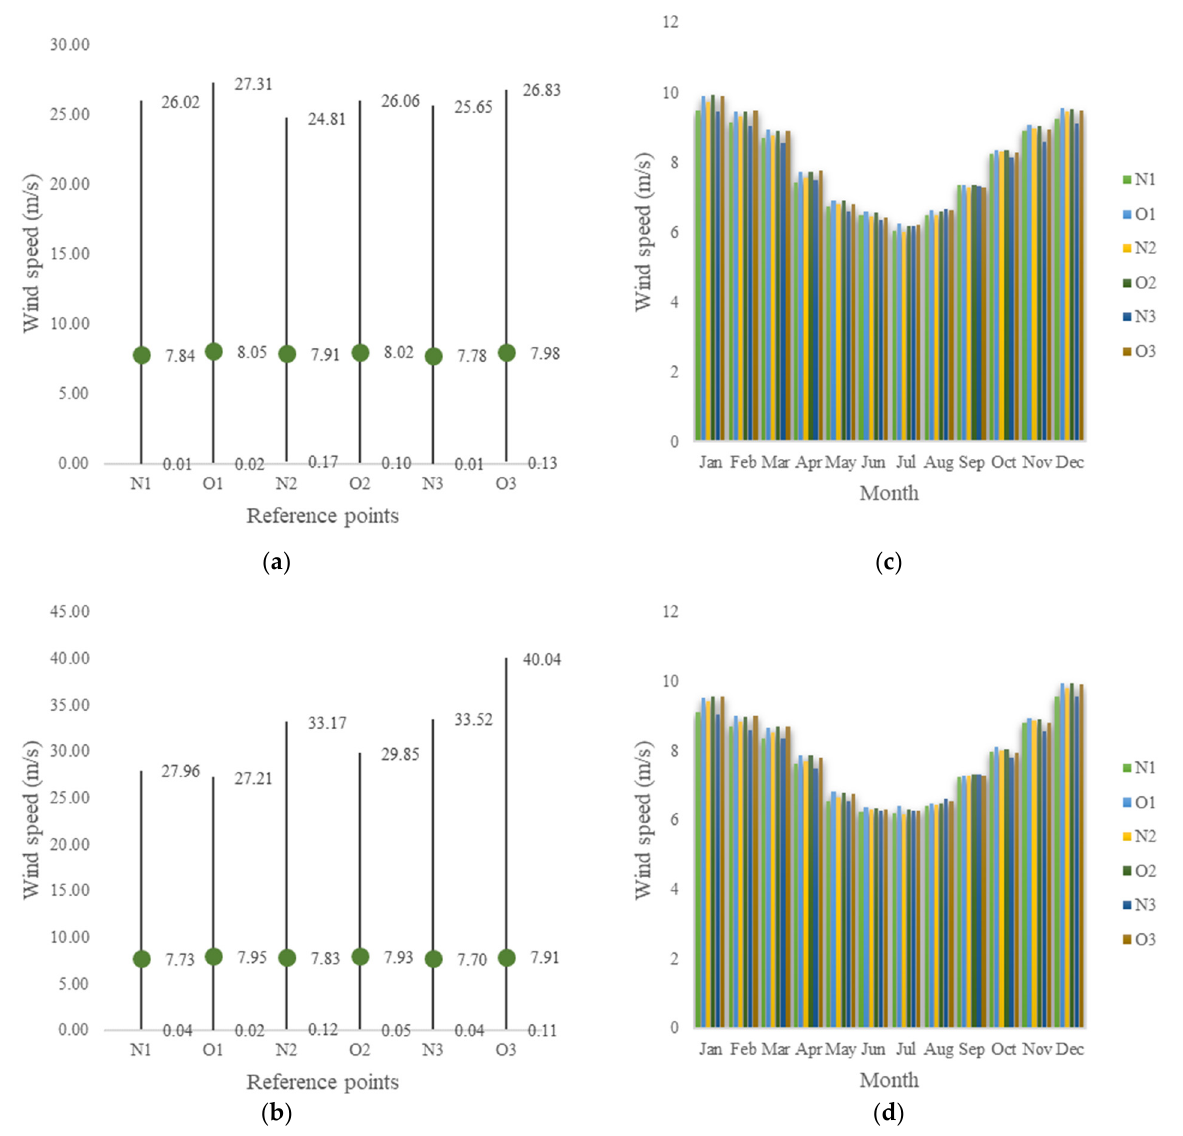
Figure 4. Wind characteristics at 90 m height ( a ) minimum, mean, maximum of the wind for the near future; ( b ) minimum, mean, maximum of the wind for the distant future; ( c ) monthly variation of the wind for the near future; ( d ) monthly variation of the wind for the distant future.